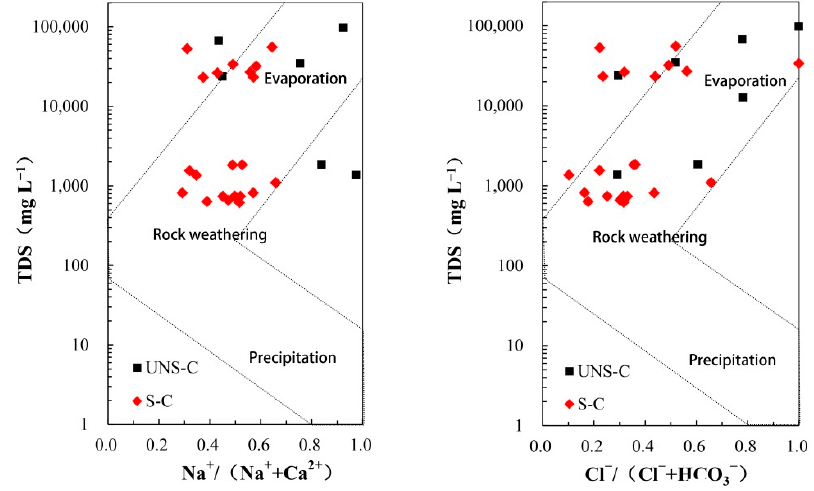
Figure 5. Gibbs diagram for the unstable catchment (UNS-C) and stable catchment (S-C) in Qingtu Lake.